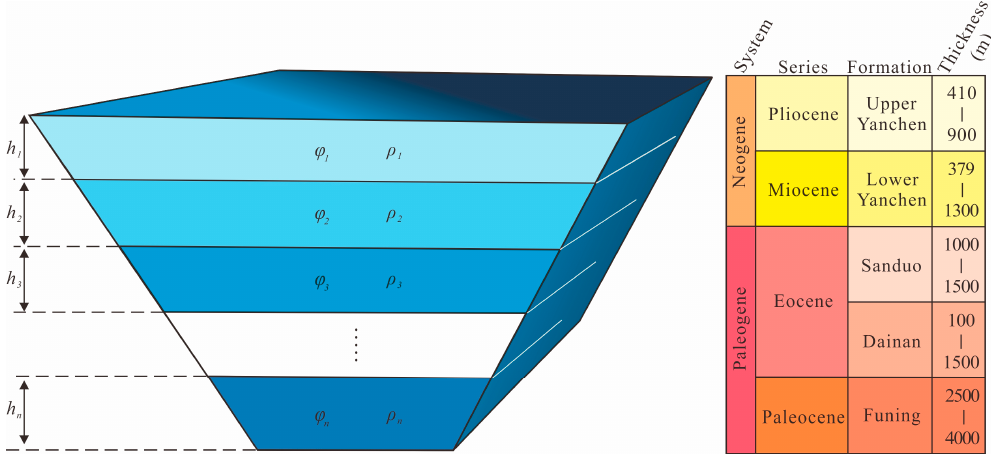
Figure 3. Formation volume model ( ϕ i is the sandstone porosity; ρ i is the carbon dioxide density; h i is the calculation unit thickness).